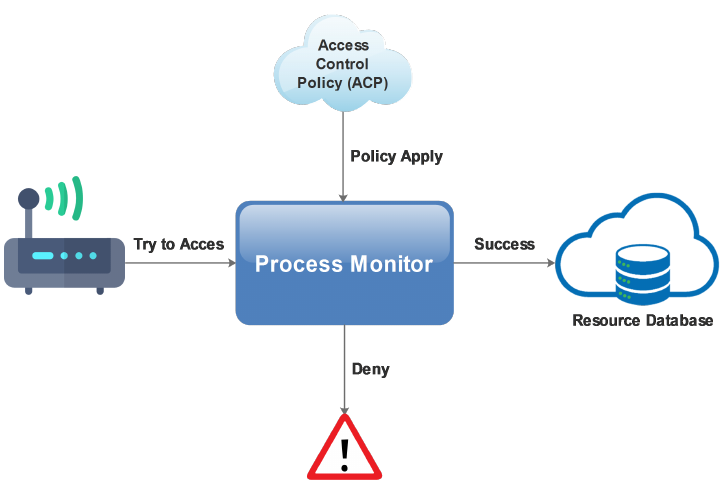
Figure 6. A process of access control